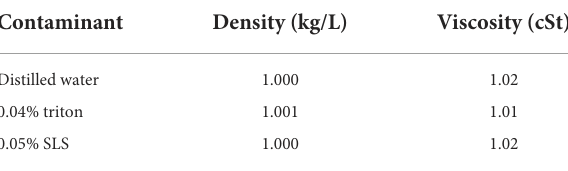
TABLE 1 Density and viscosity of the contaminants. Contaminant Density (kg/L) Viscosity (cSt) Distilled water 1.000 1.02 0.04% triton 1.001 1.01 0.05% SLS 1.000 1.02 cSt = mm 2